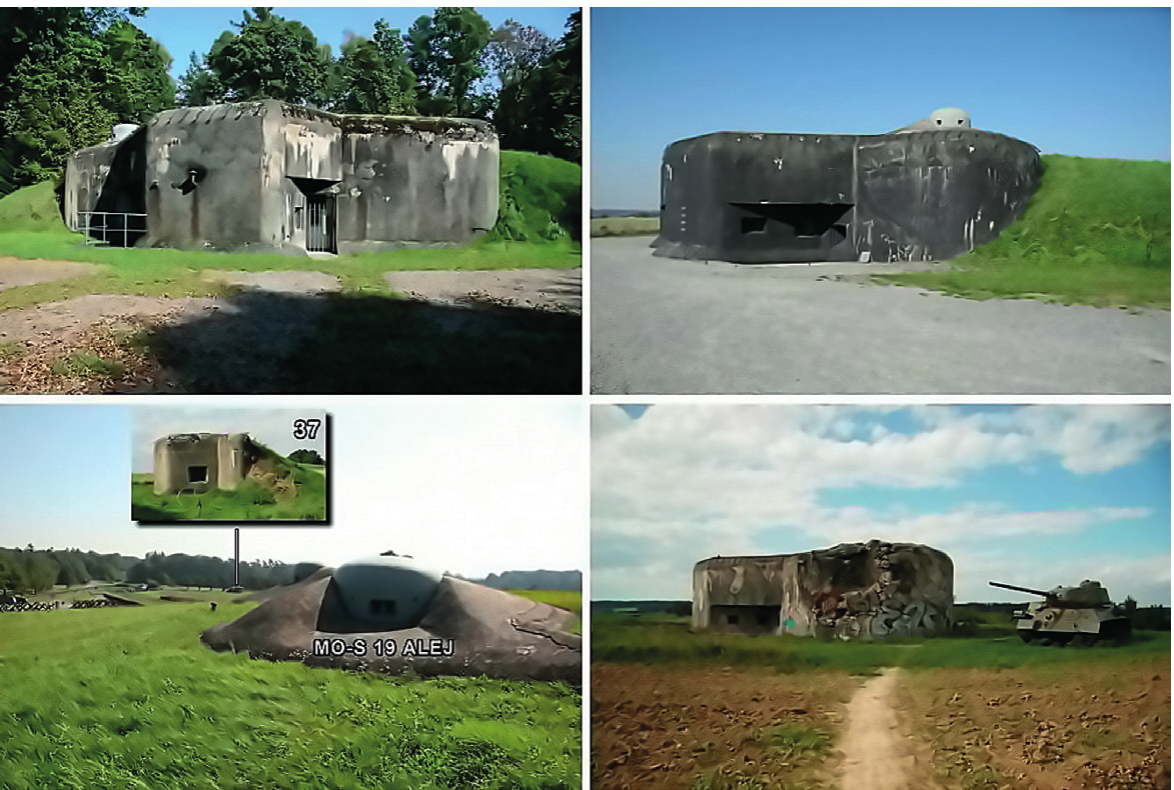
Fig. 1. Czechoslovak Border Fortifications, Hlučín-Darkovičky section. From left to right: MO-S 18 infantry cabin, MO-S 19, type 37 bunker as viewed from MO-S 19 and MO-S